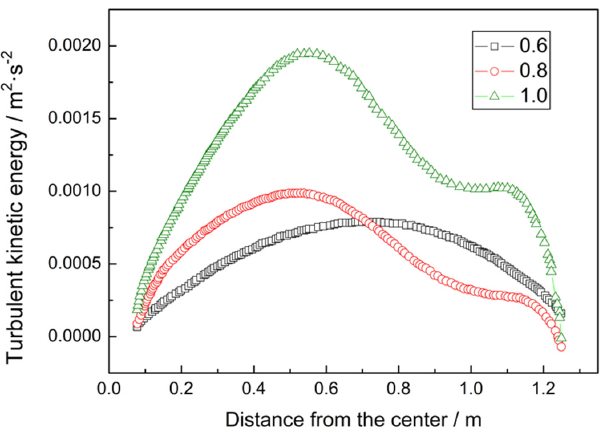
Figure 5. Turbulent kinetic energy at the free surface under different casting speeds.